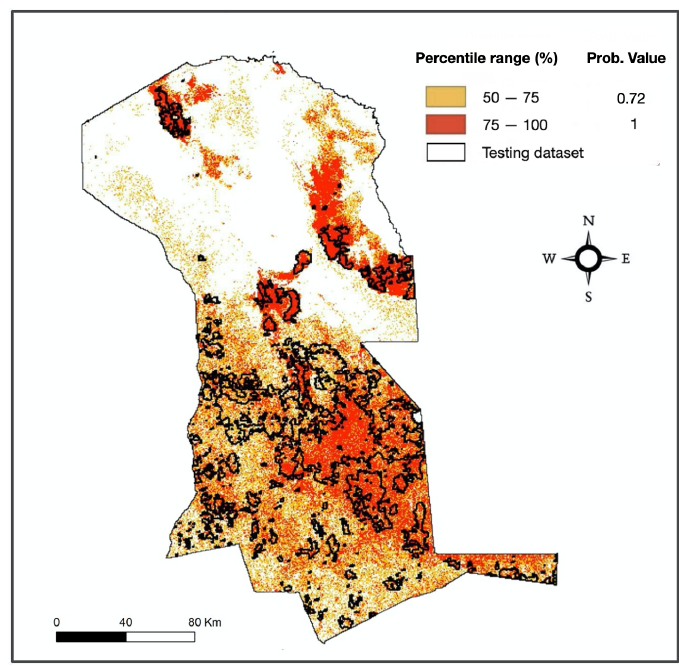
Figure 13. Performance evaluation of the RF outputs (Percentile range and corresponding Probability values) for the municipality of San Ignacio de Velasco, assessed by using the testing dataset (2017-2019 burned